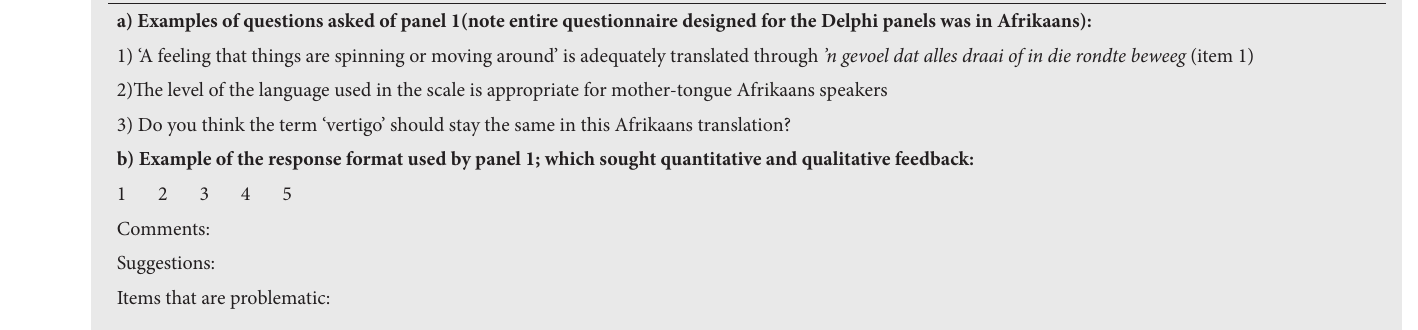
Table 2. Examples of (a) questions and (b) feedback sought from panel 1, first-language Afrikaans lay participants. The numerical Likert scale ranges from 1= ek stem verseker saam (I strongly agree) to 5= ek stem glad nie saam nie (I do not agree at